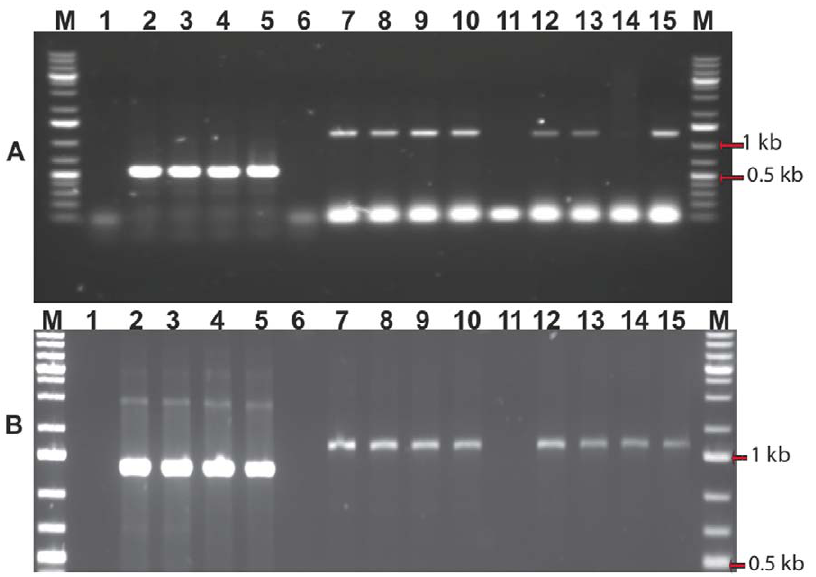
Figure 2. PCR amplification of ITS and TRI genes. Panel A: Agarose gel electrophoresis showing PCR products of ITS and TRI from four F. sambucinum strains T3, T5, T6 and T8 isolated from naturally infected potato. Lanes (2–5) show ITS PCR products from strains T3, T5, T6 and T8 respectively. Lanes (7–10) and (12–15) show TRI5 and TRI101 PCR products from T3, T5, T6 and T8 respectively. Lanes, 1, 6 and 11 are negative controls. Lane M, shows 1 Kb ladder. The PCR products for TRI4 (1.4 kb; lanes 7–10) and for TRI11 (1.5 kb; lanes 12–15) are of the expected size. Panel B: shows PCR patterns of TRI3 (lanes 2–5), TRI4 (lanes 7–10 and 12–15) from strains T3, T5, T6 and T8, respectively. Lanes, 1, 6 and 11 are negative controls. Lane M shows 1 kb ladder.